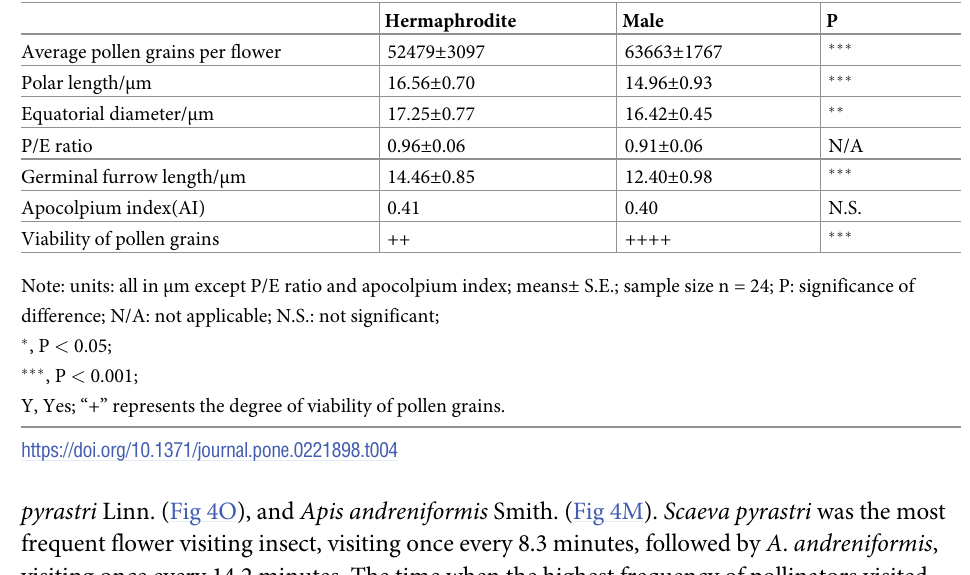
Table 4. Amount, characteristics, and viability of pollen grains for hermaphrodites and males of O . delavayi in Yunnan. Average pollen grains per flower